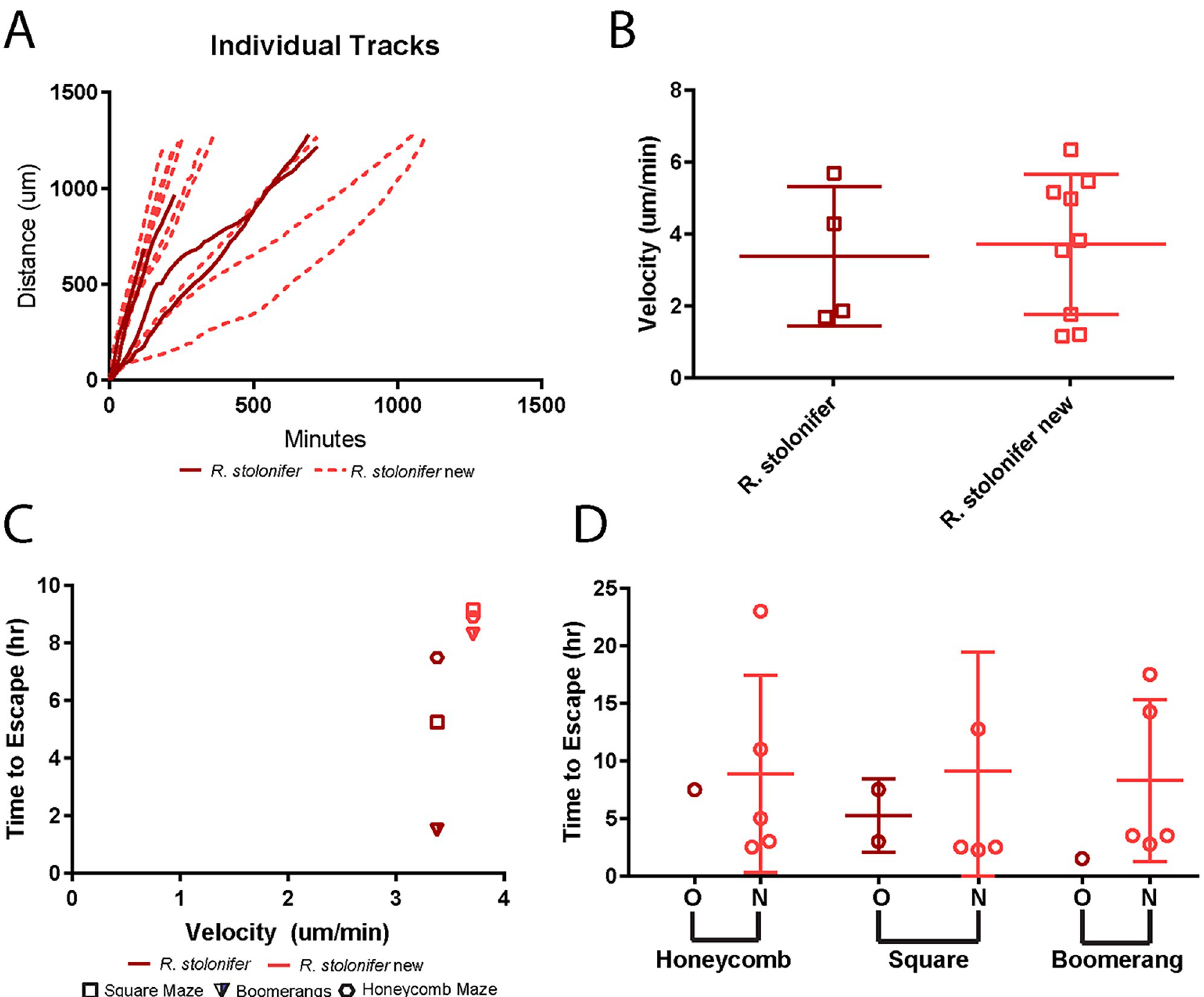
Fig 6. Reproducibility of competition results. After the initial runs by all labs, a second set of R . stolonifer experiments were conducted to establish reproducibility. (A) Individual hyphal tracks are shown for both the original runs (solid lines) and the new runs (dashed lines). (B) The average velocities were quantified. Individual dots represent the average velocity for each unique hypha in a straight channel. Error bars represent the mean ± standard deviation. (C) The average time to escape (full runs only) for each maze type is shown and plotted against the average velocity for the old and new runs. (D) The time to escape each maze is broken down to show individual maze data for old and new experiments. N = 4 hyphae, N = 2 experimental runs during the competition; N = 9 hyphae, N = 5 runs for the lab re-run for velocity data